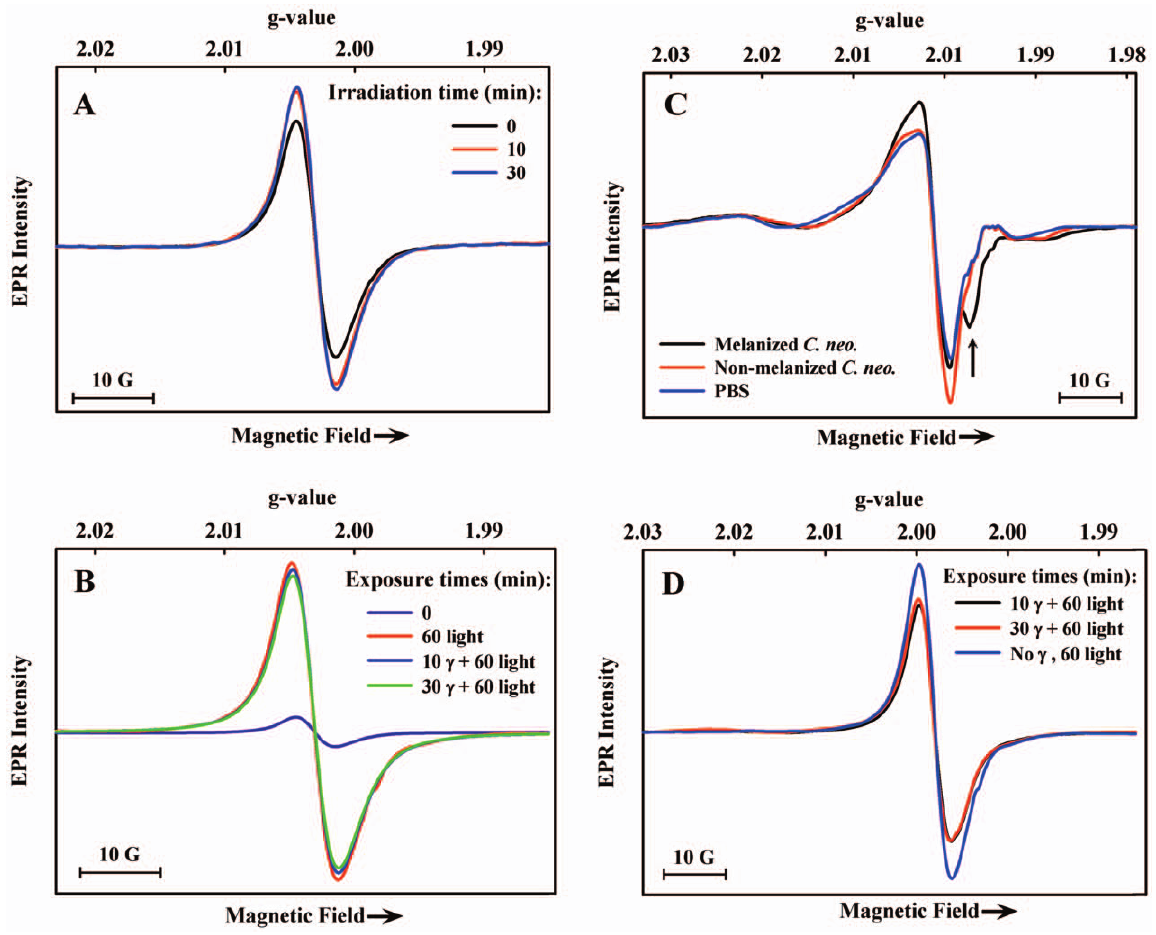
Figure 4. EPR spectra (77 K) of c -irradiated and Xe-lamp illuminated C. neoformans cells. A) melanized cells c -irradiated at room temperature (11.94 Gy/min), then frozen in liquid nitrogen; B) c -irradiated melanized cells from (A) illuminated for the indicated time periods after freezing at 77 K; C) c -irradiated (11.94 Gy/min) frozen (77 K) melanized cells, non-melanized cells, and PBS; D) c -irradiated melanized cells from (C) stored frozen for 2 weeks then illuminated at 77 K for the indicated time